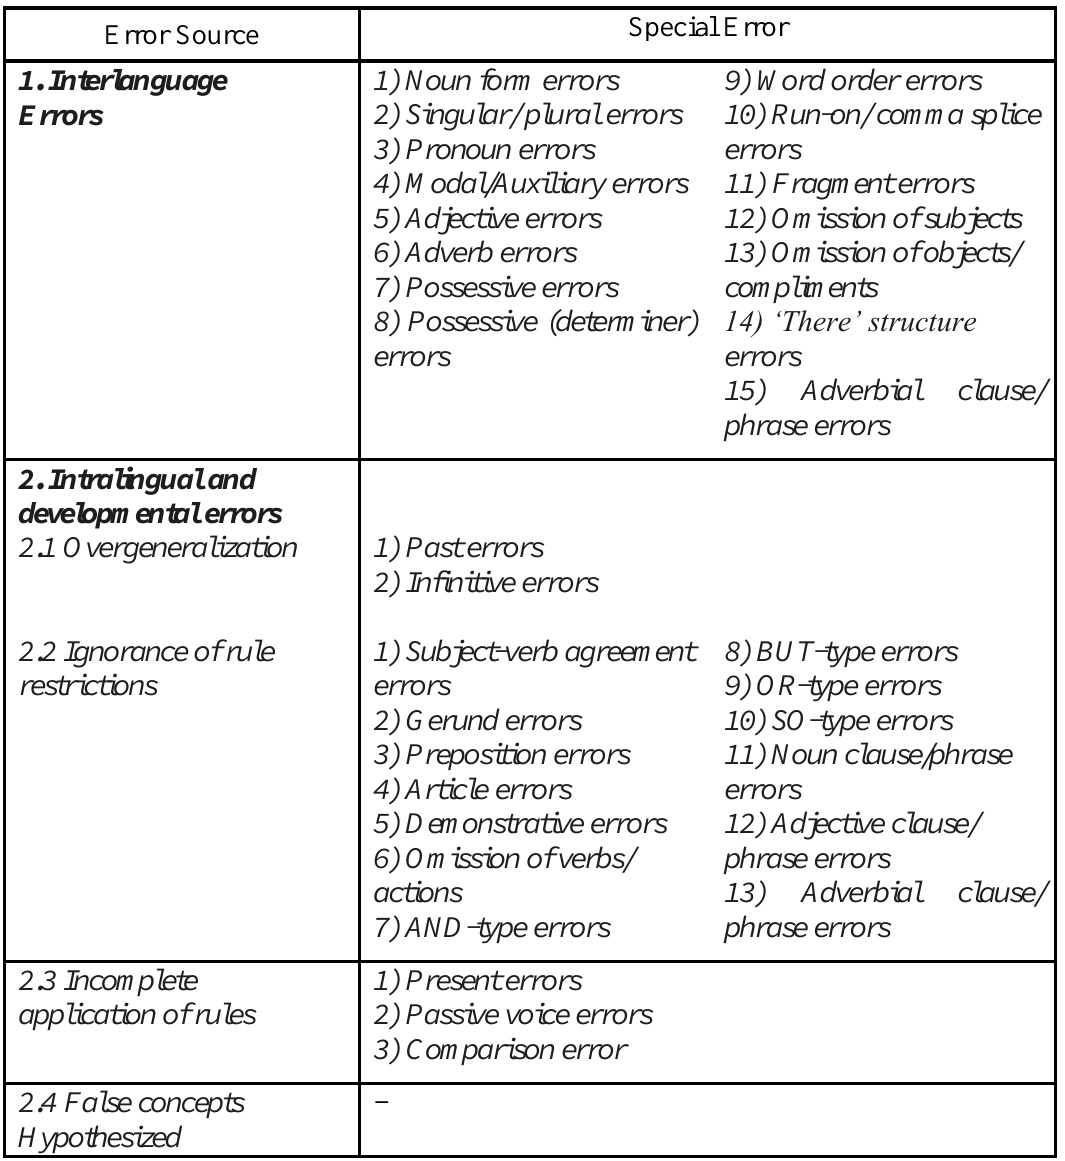
Table 3. Sources of specific errors in students’